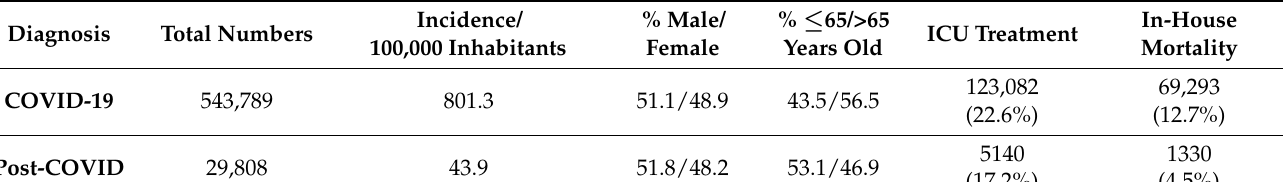
Table 1. Number of cases diagnosed with COVID-19 and Post-COVID syndrome.